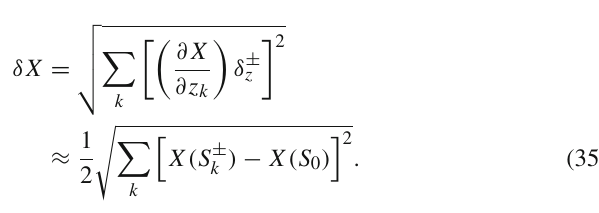
Table 3 The parameters δ z ±